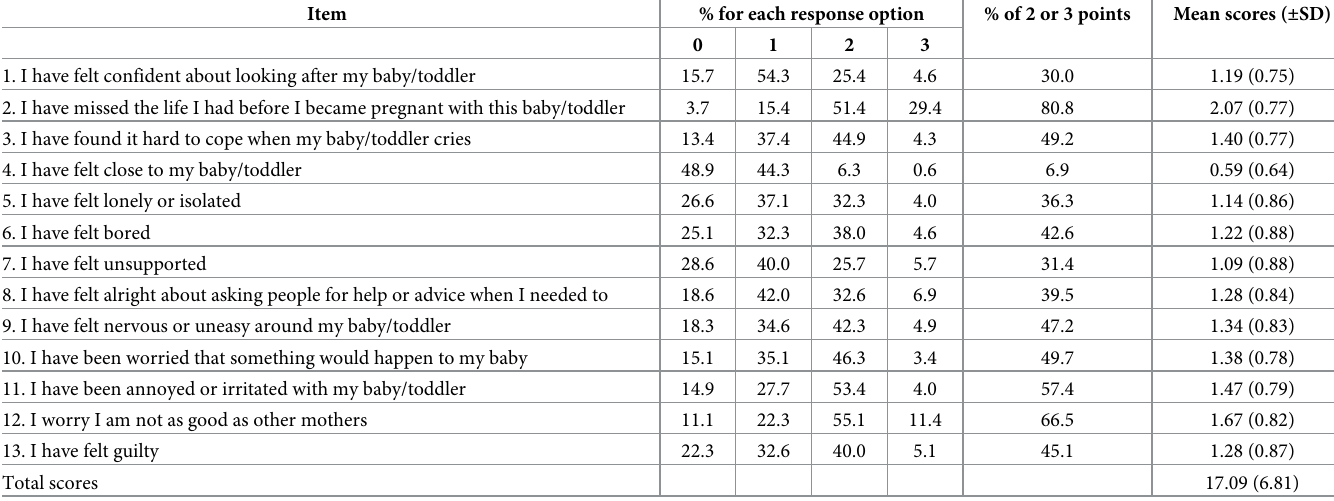
Table 2. Percentage (%) and mean score for each response � to the BaM-13 items among 350 Korean women with young children. Item % for each response option